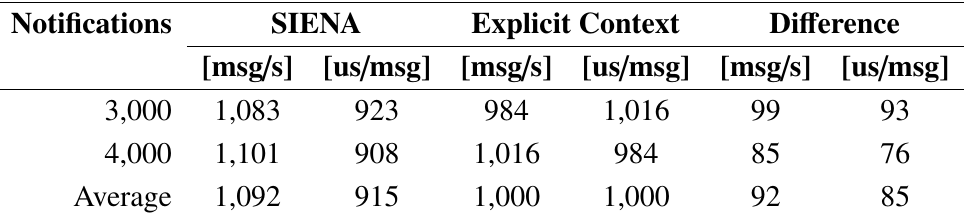
Table 1. Numerical result of test with 80,000